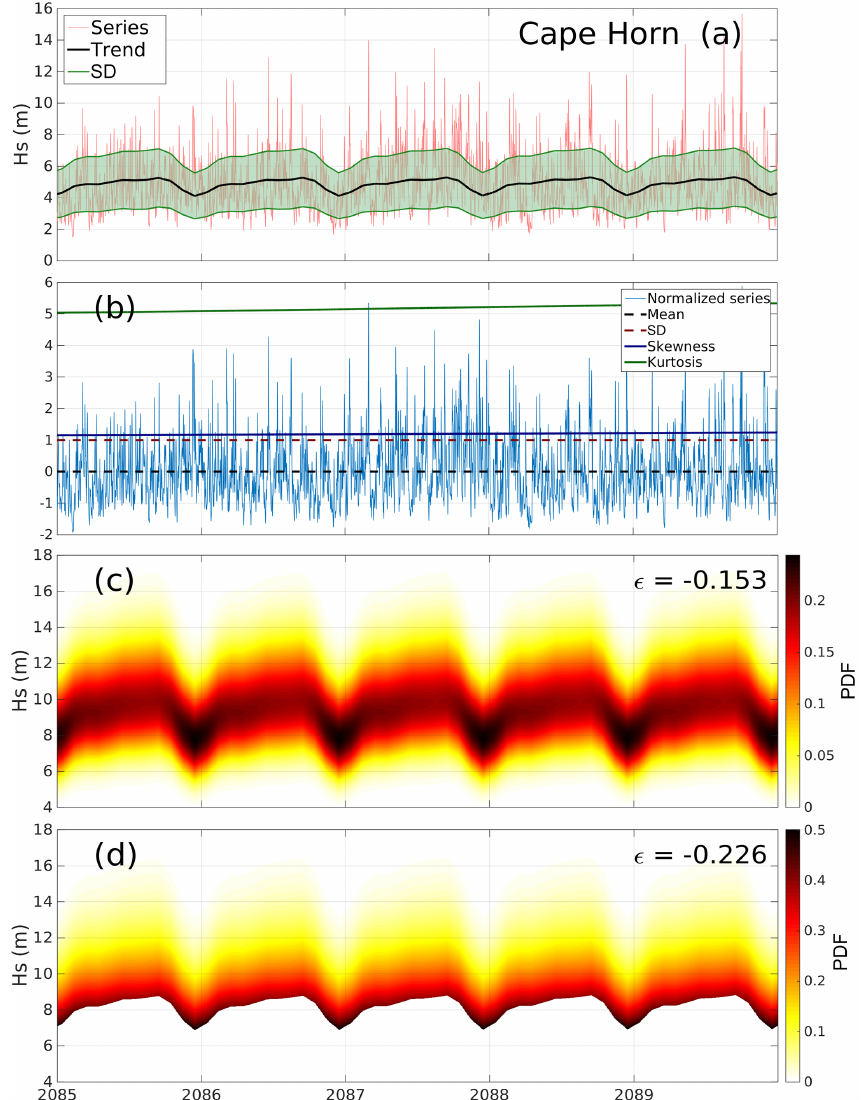
Figure 5. Seasonal analysis of the projections of significant wave height in Cape Horn: (a) series, its trend, and standard deviation; (b) the normalized series with higher order statistical indicators; (c) non-stationary GEV of annual maxima; (d) non-stationary GPD of annual peaks. In (c) and (d) the values of the shape parameter ε best fitted for the GEV and GPD distributions are reported. For the sake of clarity, only a 5-year time slice is